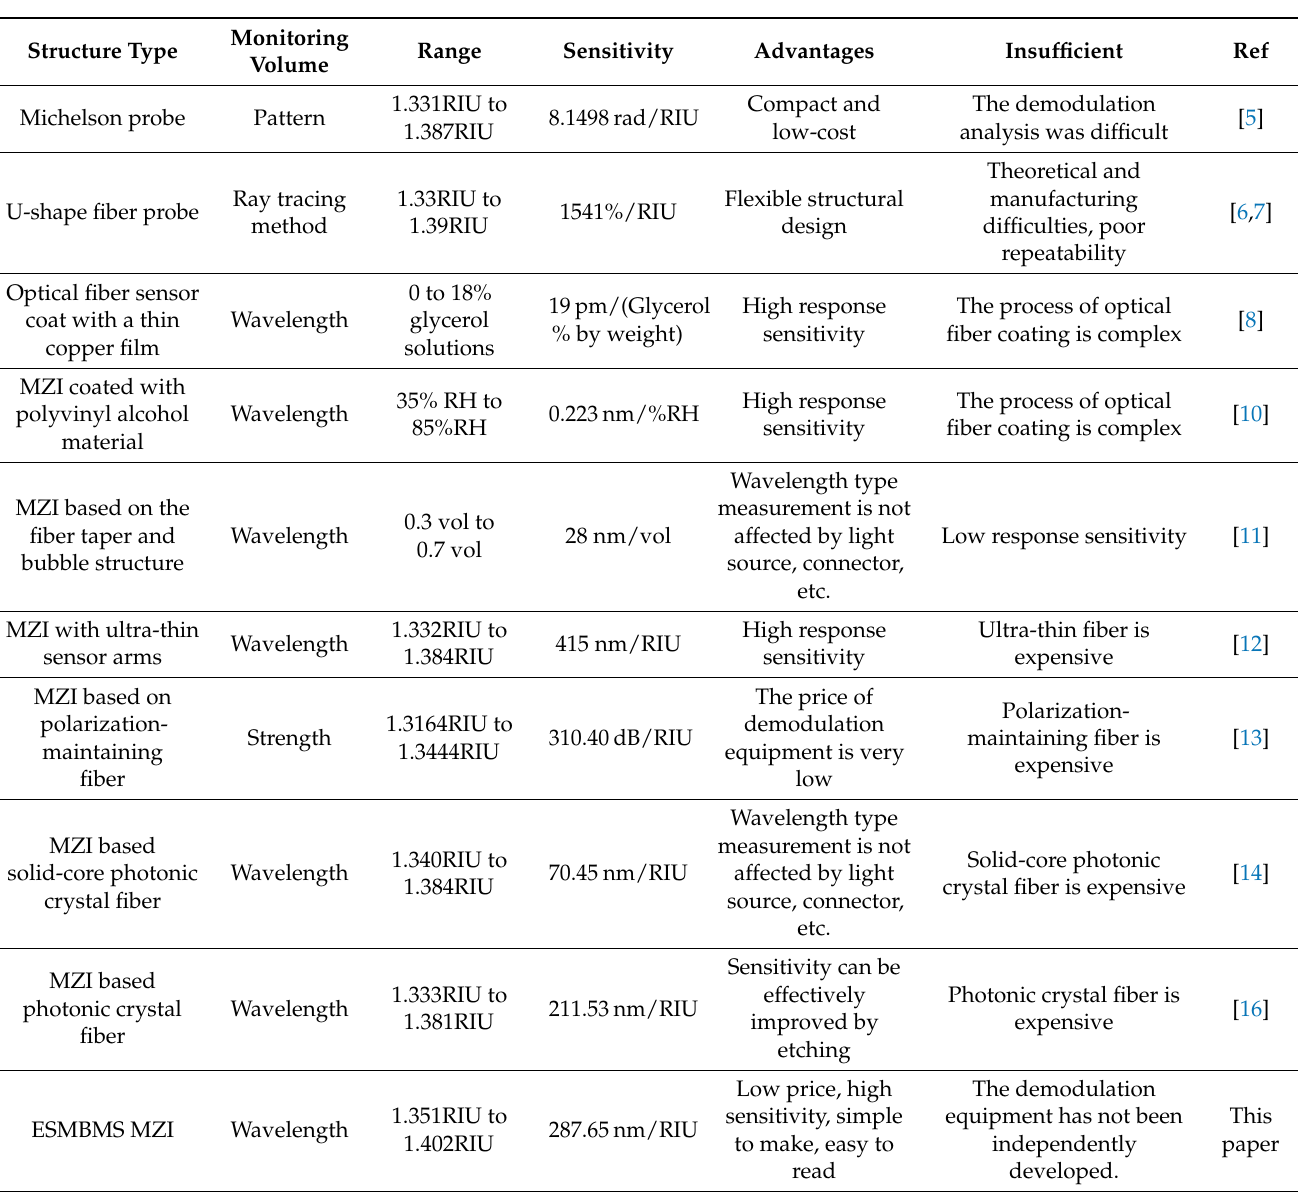
Table 1. Comparison of various refractive index